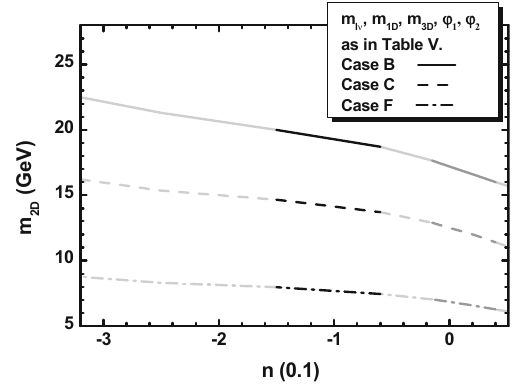
Fig. 6 Contours in the n − m 2D plane yielding the central Y B in Eq. (88) consistently with the inflationary requirements for K = K 2 or K 3 , λ μ = 10 − 6 , y = 0 . 5 and the values of m ϕ ϕ i ν , m 1D , m 3D , 3 1 , and 2 which correspond to the cases B (solid line), C (dashed line), and F (dot-dashed line) of Table 6. The color coding is as in Fig. 3.